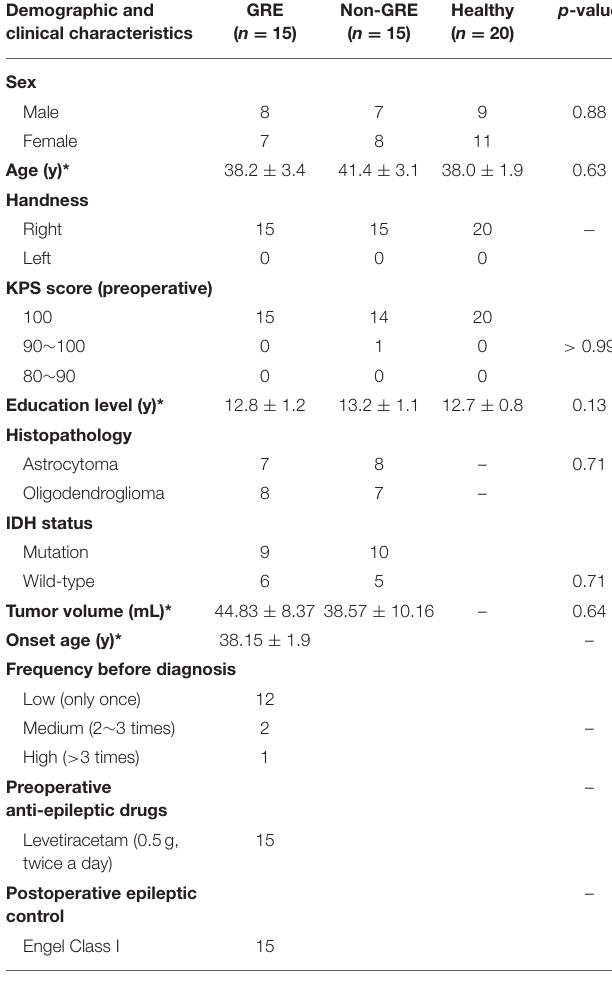
TABLE 1 | Demographic and clinical characteristics of patient